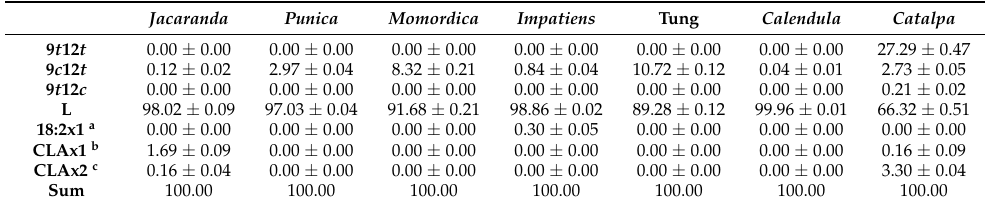
Table 4. 18:2 Isomer distribution. Entries are percentages of the total integrated 18:2 FID signal and the means of three independent determinations. Uncertainties are 95% confidence limits based on the t -distribution with 2 degrees of freedom.